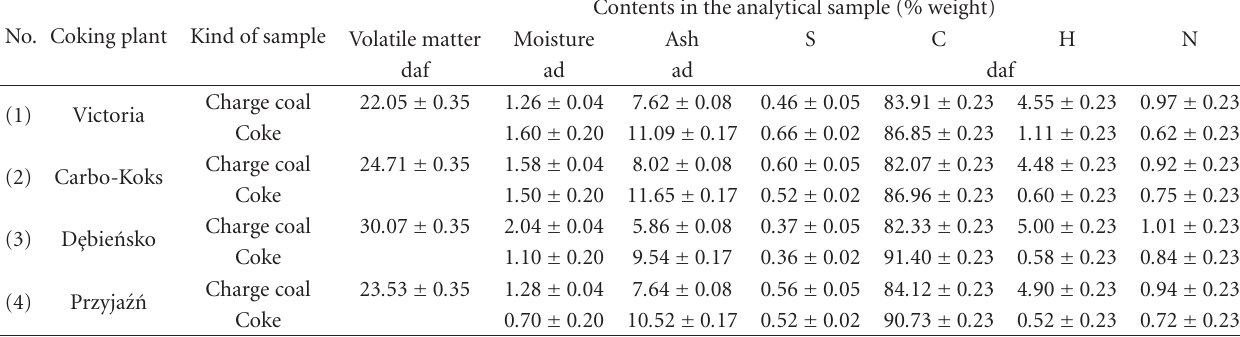
Table 3: Results of the technical and elemental analysis of the tested charge coal and coke and uncertainty of the results. No. Coking plant Kind of